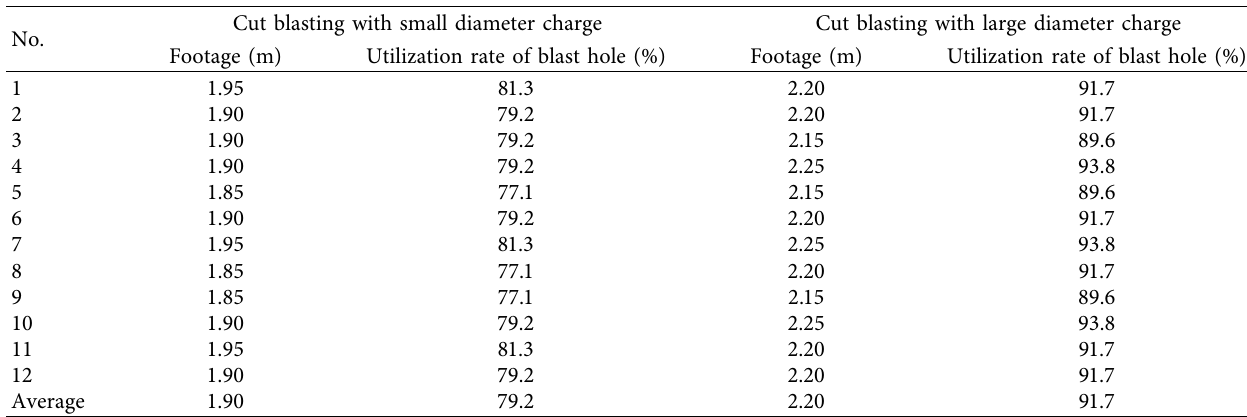
Figure 9: Construction operations of field tests. (a) Check of hole space. (b) Check of hole depth. (c) Charge of blast holes. (d) Measurement of footage. Table 9: Comparative data of blasting